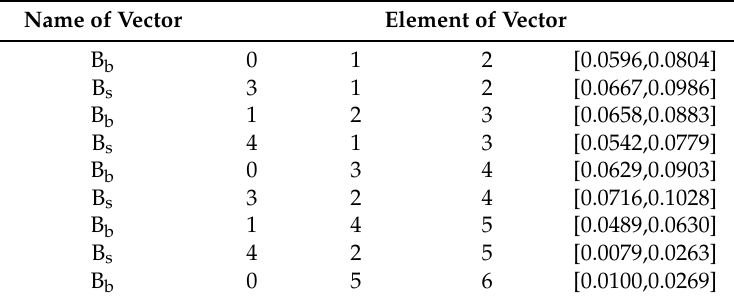
Table 10. Identification template 3 for water